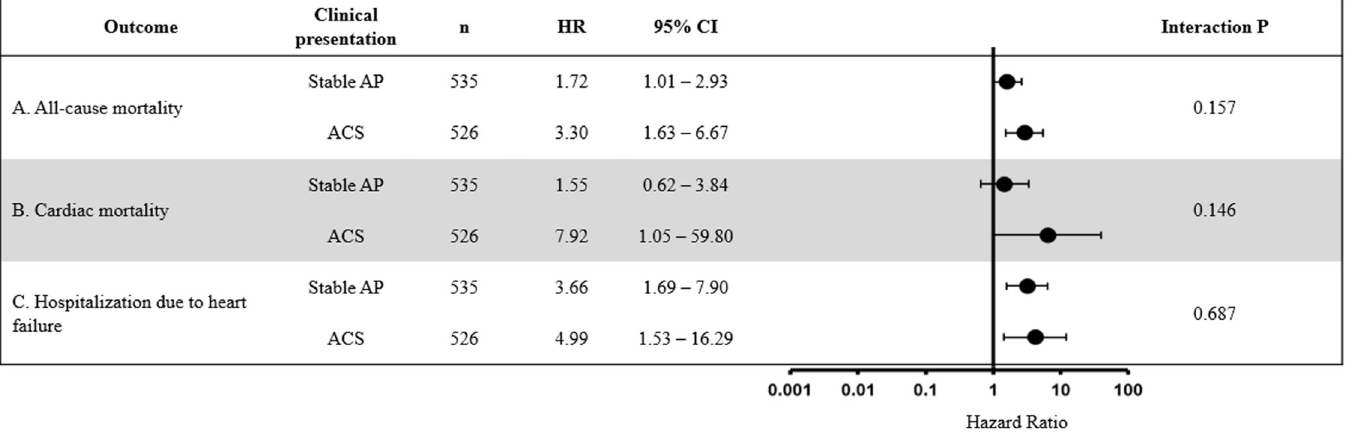
Fig 3. Forest plot of hazard ratios by clinical presentations. HR, hazard ratio; CI, confidence interval; AP, angina pectoris; ACS, acute coronary syndrome.